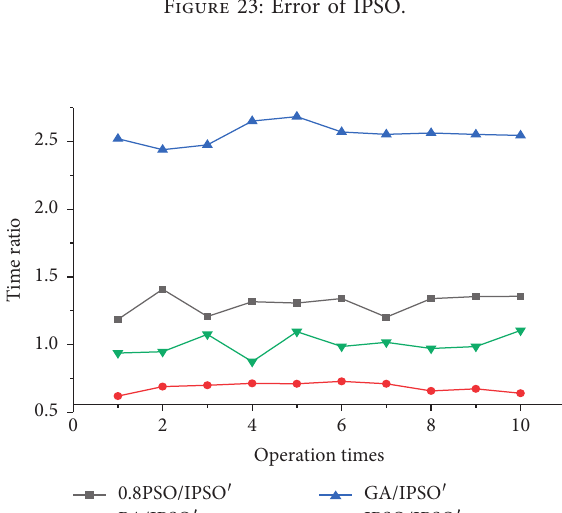
Figure 21: Error of BA.